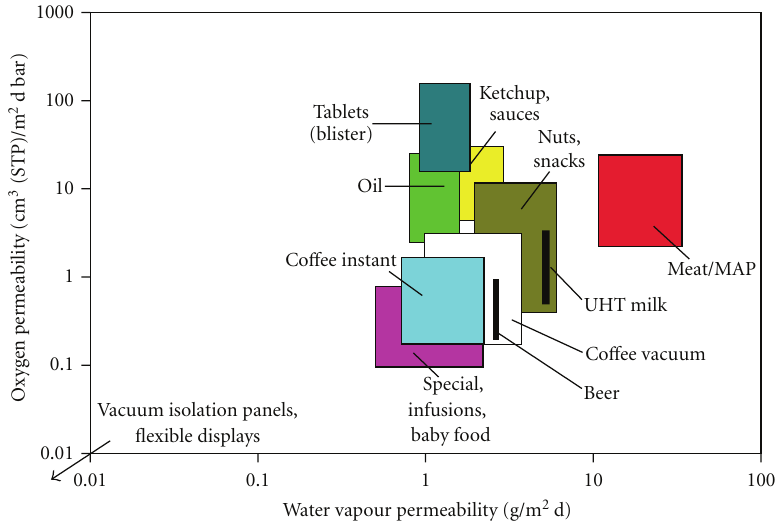
Figure 1: Barrier requirements of selected food and